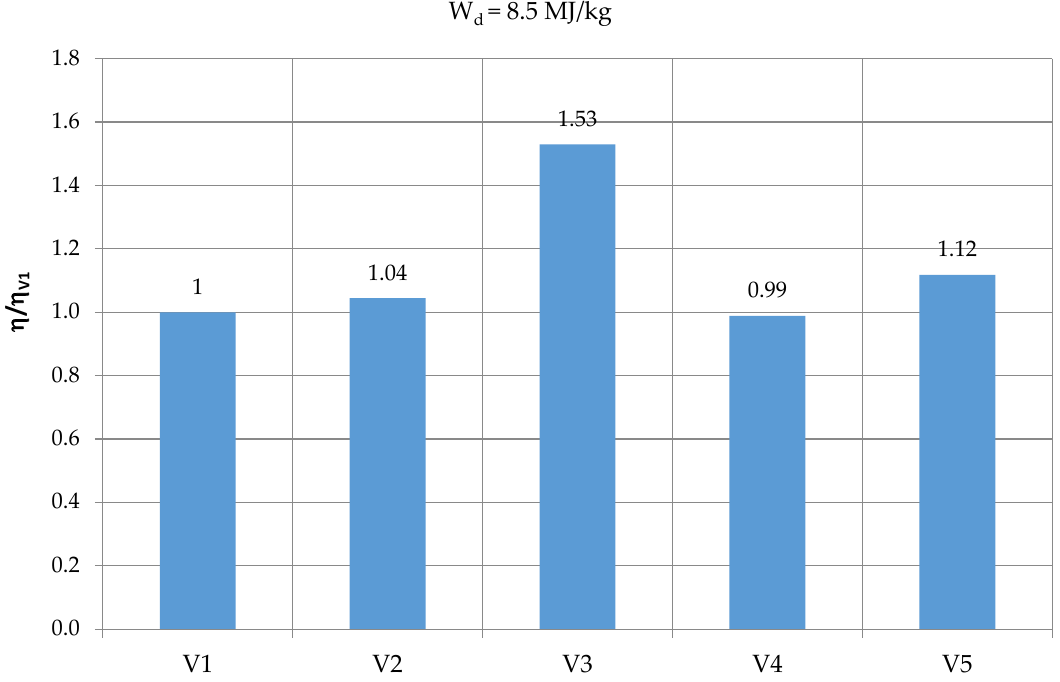
Figure 5. Influence of the cycle structure on its efficiency as compared to variant 1 for heating value W d = 8.5 MJ/kg.